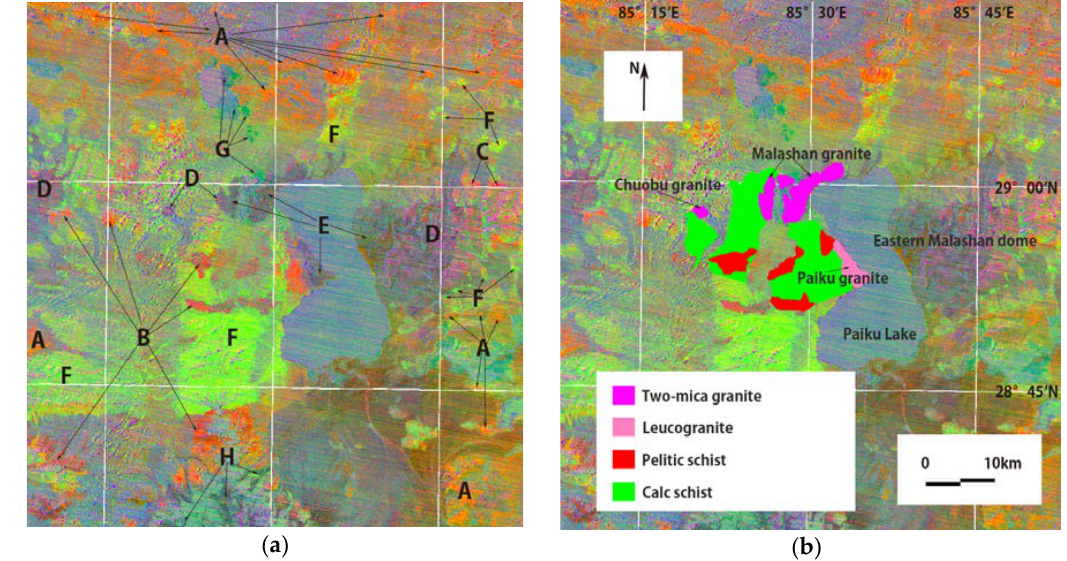
Figure 10. ( a ) Lithological mapping with the mosaic color composite image of QI, CI and MI around the Malashan domes. The coverage of this image is indicated in Figure 8. The interpreted rock types with this image are A: Quartzose sedimentary layers related to the Tethys, colored yellowish-red; B: Low-grade metamorphic quartzose Tethyan sediments related to the intrusion, colored pure red; C: High-grade metamorphic quartzose Tethyan sediments around metamorphic domes, colored pinkish-red; D: Relatively feldspar-poor granitic rocks related to the domes, colored dark pinkish-purple; E: Feldspar-rich granitic rocks around the domes, colored dark bluish-green; F: Carbonate layers related to the Tethys, colored light green; G: Sulfate deposits, colored deep green; H: Feldspar-rich granitic rocks at the glacier valleys in the north slope of the Himalaya Mountains; ( b ) Geological map around the western Malashan metamorphic dome area investigated by Aoya et al. [37] embedded in the color composite image of the indices.